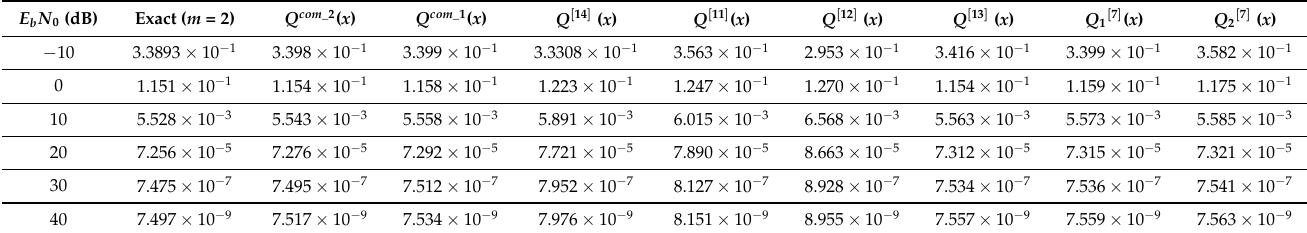
Table 3. Comparison of ASEP values over Nakagami- m fading channels for parameter m = 2, obtained by applying our Q -function approximations and selected ones from the literature.